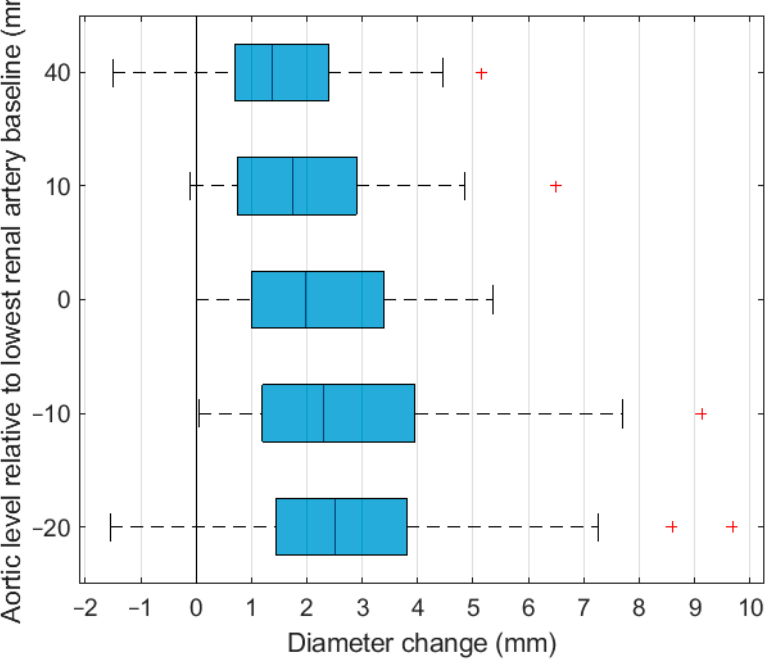
Figure 2. Diameter change at five aortic levels on the first computed tomography angiography scan after endovascular aneurysm repair.